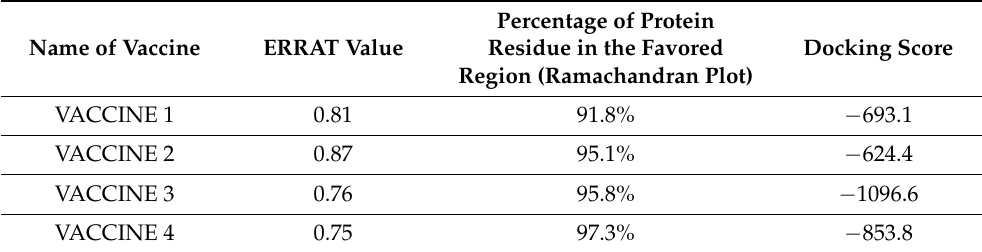
Table 4. The ramachandran plot, ERRAT values, and Docking Scores with Human TLRs of respec- tive